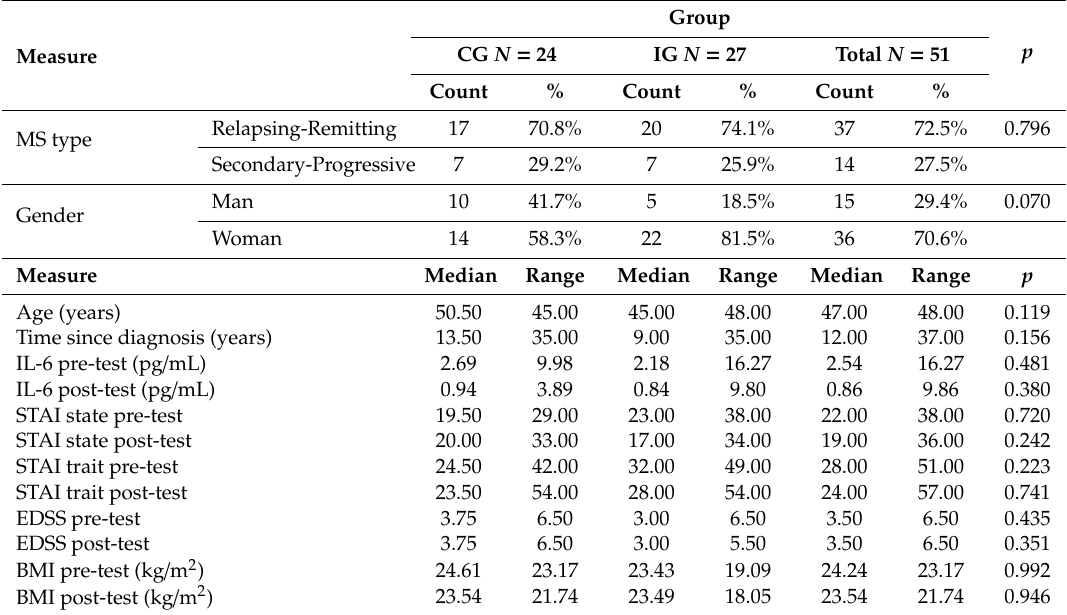
Table 1. Socio-demographic and clinical characteristics of the population of the